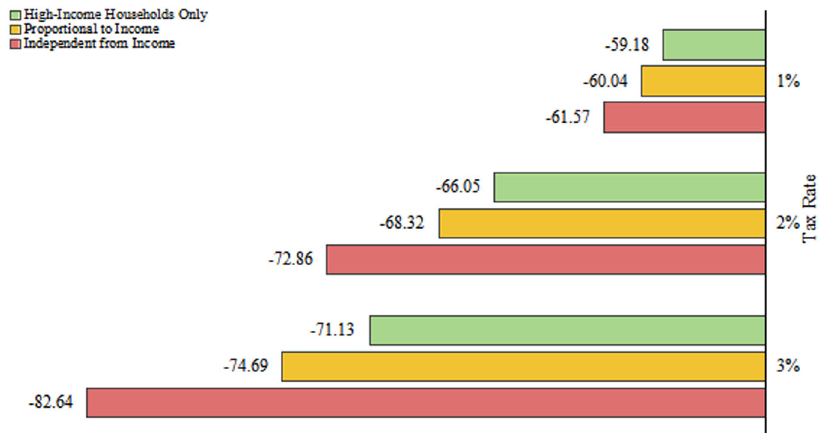
Fig. 4 Impacts of tax payments on relative utility (unit: 10 9 CNY). Shows impacts of tax payments on relative utility: the legends “ High-income Households Only ” , “ Proportional to Income ” , and “ Independent from Income ” refer to tax payments by high-income households, proportional to income, and independent from